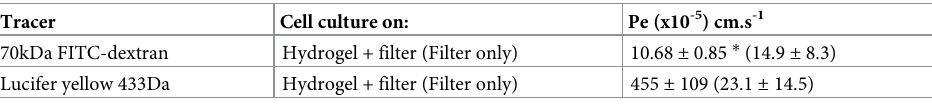
Table 4. Permeability of hydrogel cultures to paracellular